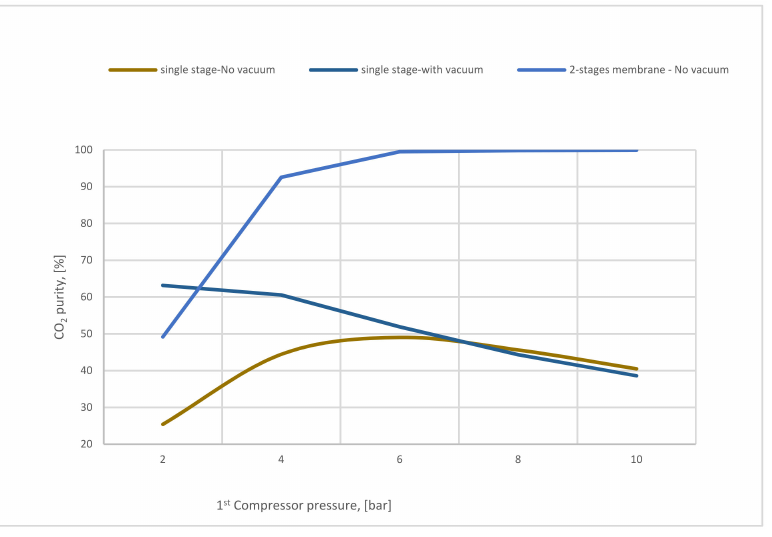
Figure 19. The variation of CO 2 purity at 400,000 m 2 of SA 1 and 5000 m 2 of SA 2 based on 1st compressor pressure.